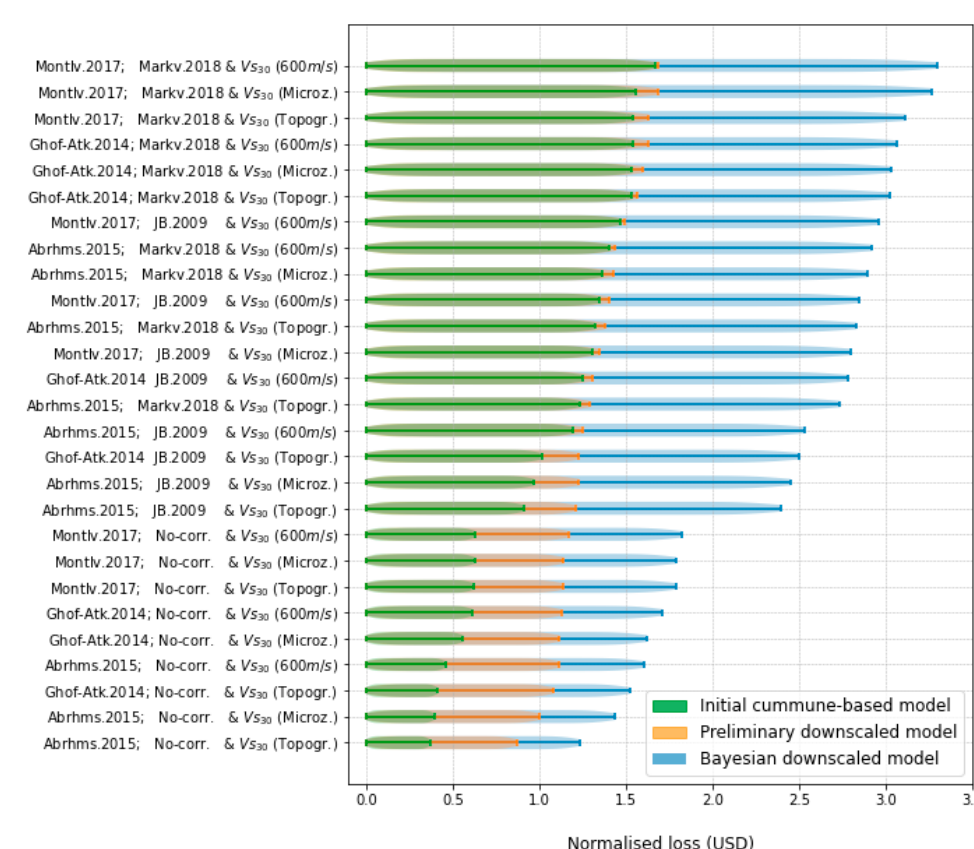
Figure 16. Similar information to that shown in Figure 15, showing the normalised loss differences between each exposure model.